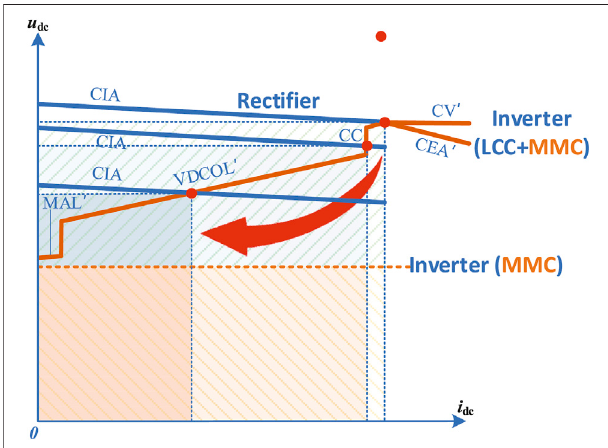
FIGURE 6 | transient characteristic when AC fault happens at recti fi er